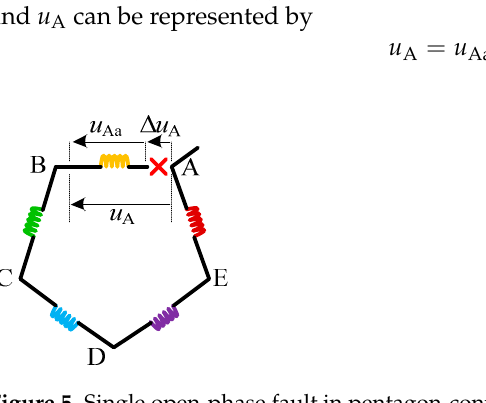
Figure 5. Single open-phase fault in pentagon-connection